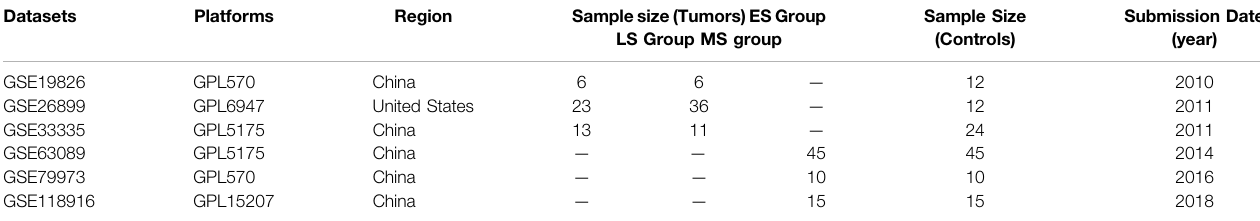
TABLE 1 | Characteristics of included GEO